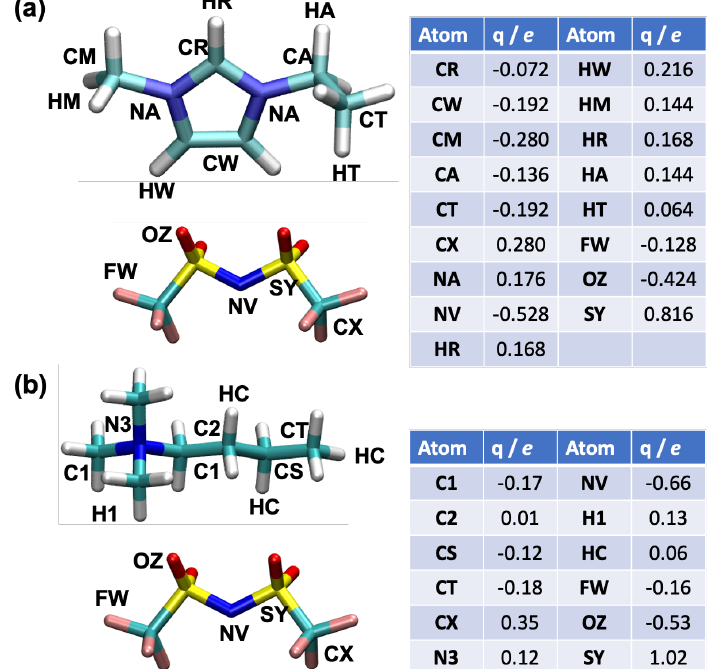
Figure 2. Chemical structure and partial atomic charges ( q ) for the atoms of ions in the ionic liquids reference points in the mass density distribution